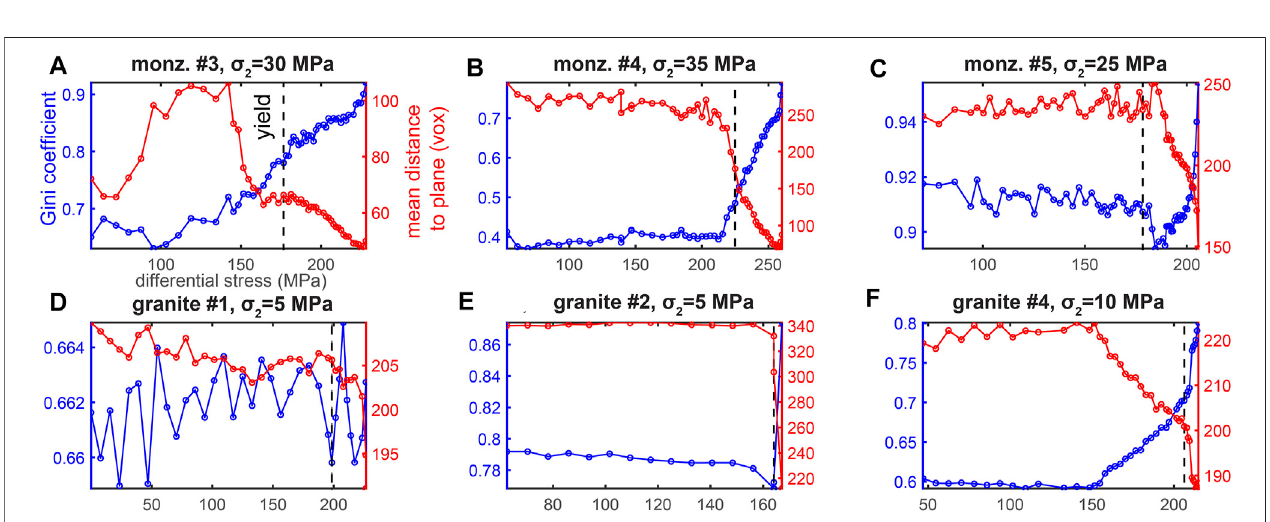
FIGURE 11 | Evolution of the Gini coef fi cient and mean distance to the fi nal failure plane in each experiment. Increasing Gini coef fi cient indicates increasing localization, while decreasing distance indicates increasing localization. Vertical black dashed lines indicate the macroscopic yield point.